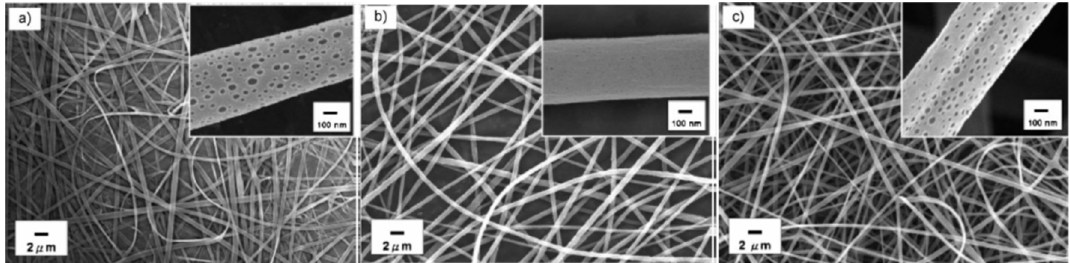
Figure 36. SEM images from electrospun nanofibres for PMMA concentrations in DMF solutions of ( a ) 0.32 mg/mL and ( b ) 0.18 mg/mL; ( c ) final fibres when the PMMA/PANI complex is synthetized. Reprinted from [167] with permission from Elsevier.